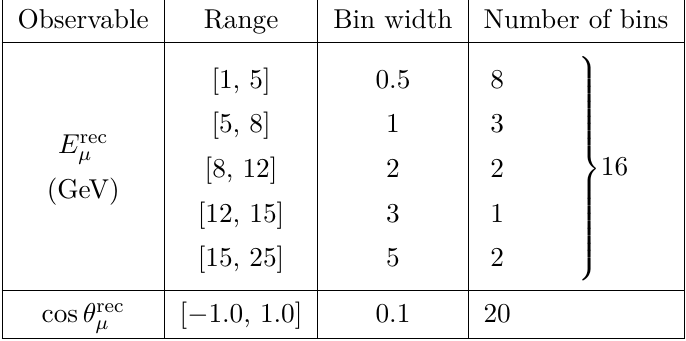
Table 4 . The binning scheme adopted for E rec